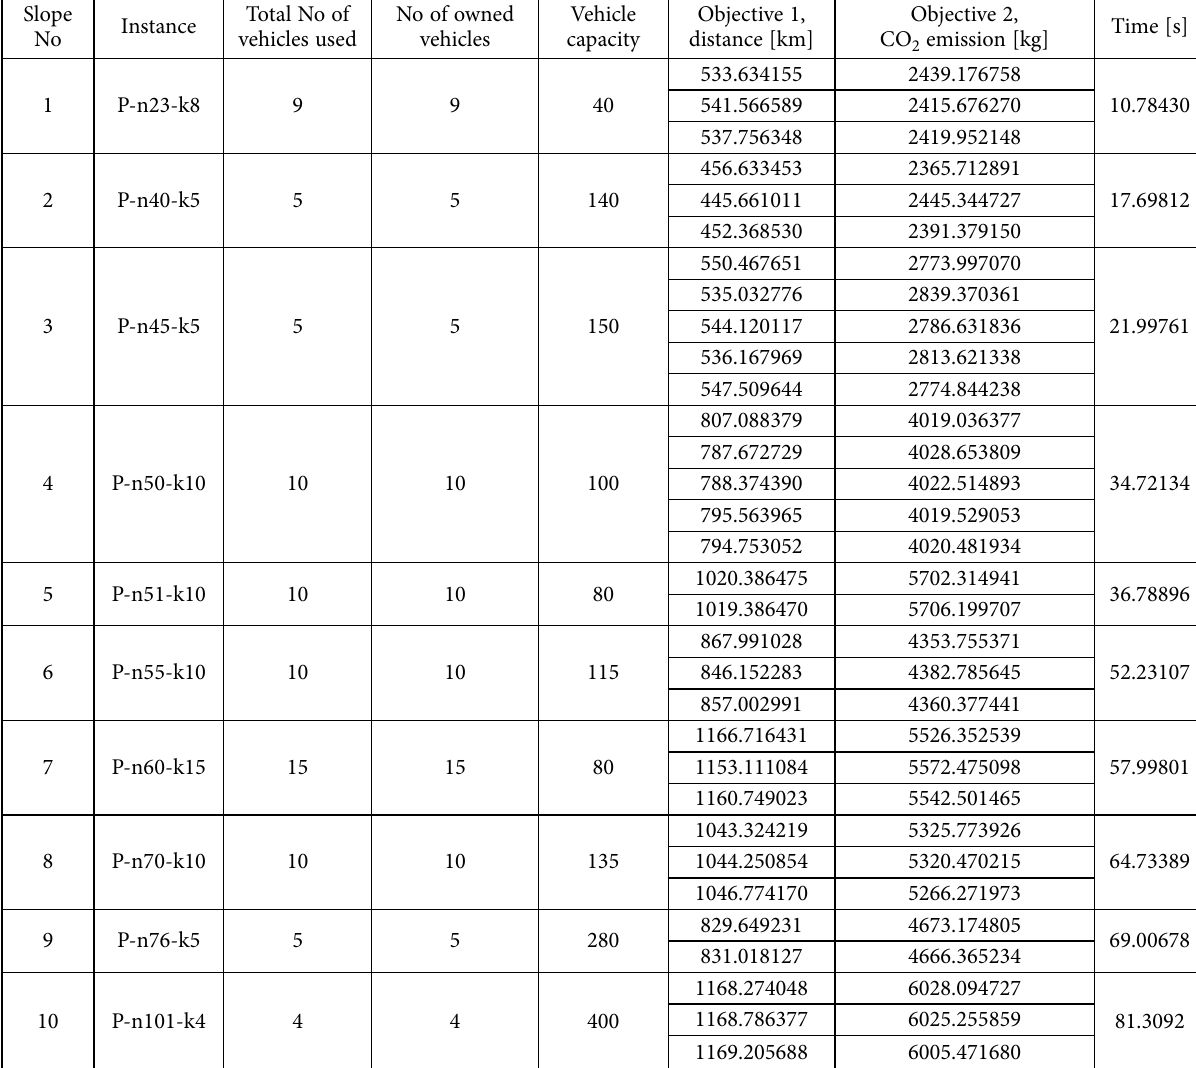
Table 1. Results of independent runs of the multi-objective fully closed G-VRP